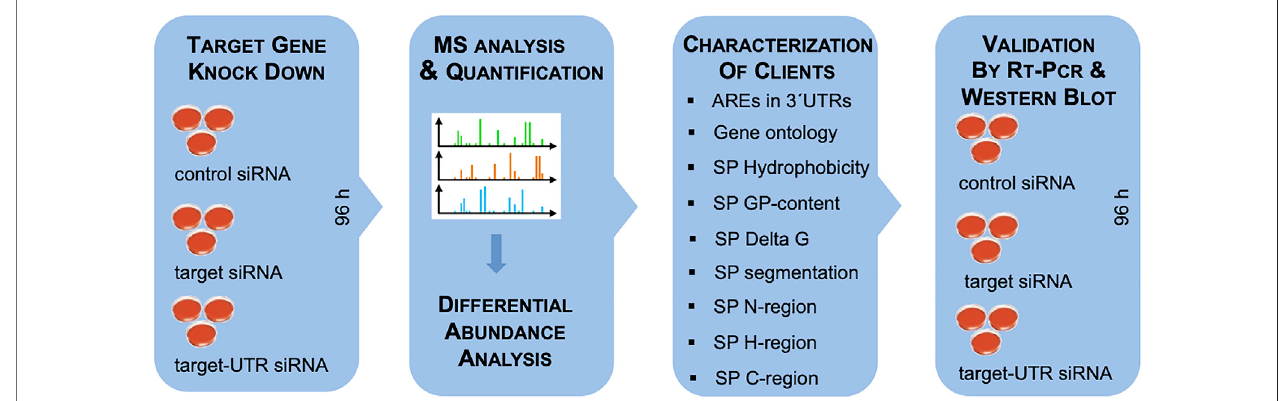
FIGURE 4 | Experimental strategy. The experimental strategy involved i) siRNA-mediated gene silencing using two different siRNAs for each target and one non- targeting (control) siRNA, respectively, with three replicates for each siRNA for 96 h; ii) label-free quantitative analysis of the total cellular proteome; iii) differential protein abundance analysis to identify negatively affected proteins (i.e., putative substrates or clients of the target) and positively affected proteins (i.e., putative compensatory mechanisms); iv) independent validation by western blot. For characterization of substrates, genes were screened for AU-rich elements (ATTTA motifs) in 3 ′ UTRs using the AREsite2 database (http://rna.tbi.univie.ac.at/AREsite2/welcome) and SPs were analyzed for hydrophobicity according to Kyte and Doolittle, (1982) (https:// www.bioinformatics.org/sms2/protein_gravy.html), GP-content (Nguyen et al., 2018), apparent Delta G for membrane insertion of TMHs (http://dgpred.cbr.su.se), or segmentation (https://phobius.sbc.su.se) in combination with characterization of the SP segments with the same tools as above.